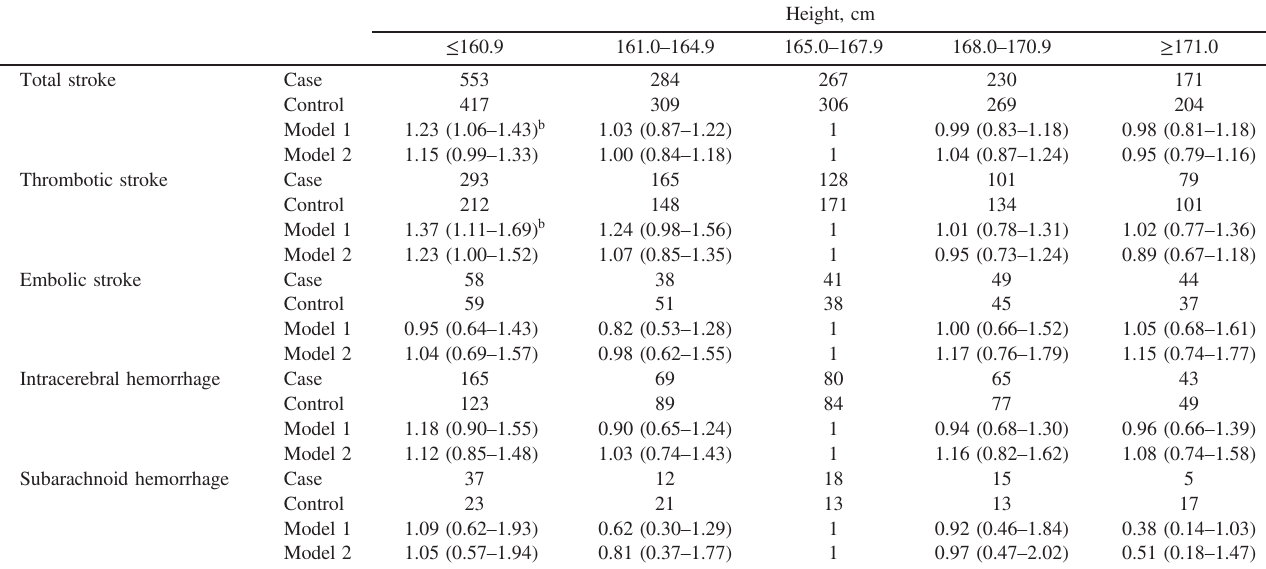
Table 3B. Multivariable-adjusted odds ratios and 95% con fi dence intervals of stroke and its subtypes according to height in men aged 60 – 79 years, Aichi,